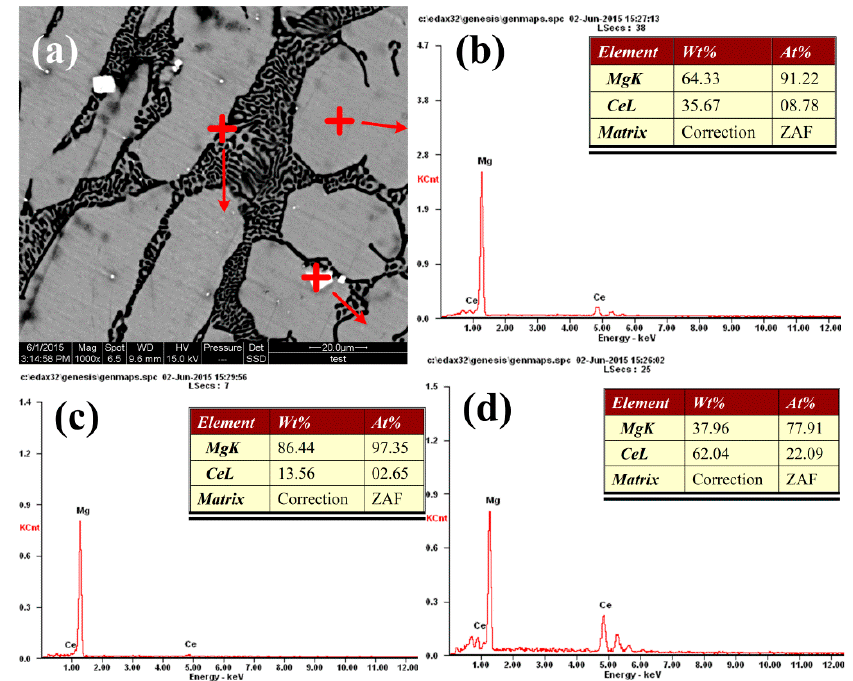
Figure 4. Scanning electron microscopy and energy spectrum analysis images of Mg–30%Ce: ( a ) Mg–30%Ce, ( b ) Analysis of gray-white phase energy spectrum in Mg–30%Ce, ( c ) Analysis of black network phase energy spectrum in Mg–30%Ce, and ( d ) Phase energy spectrum analysis of bright white particles in Mg–30%Ce.